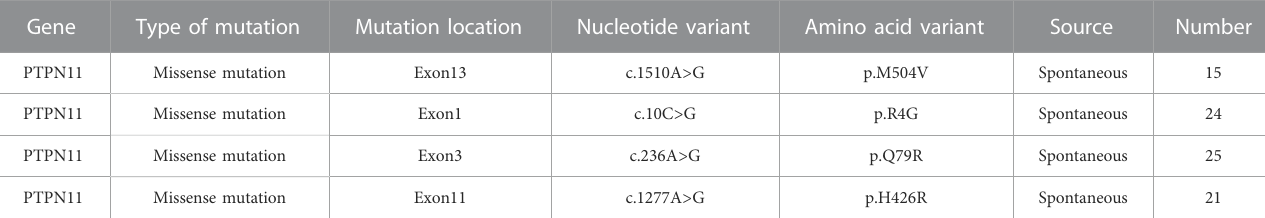
TABLE 4 Deafness causative genes and number of cases in NS